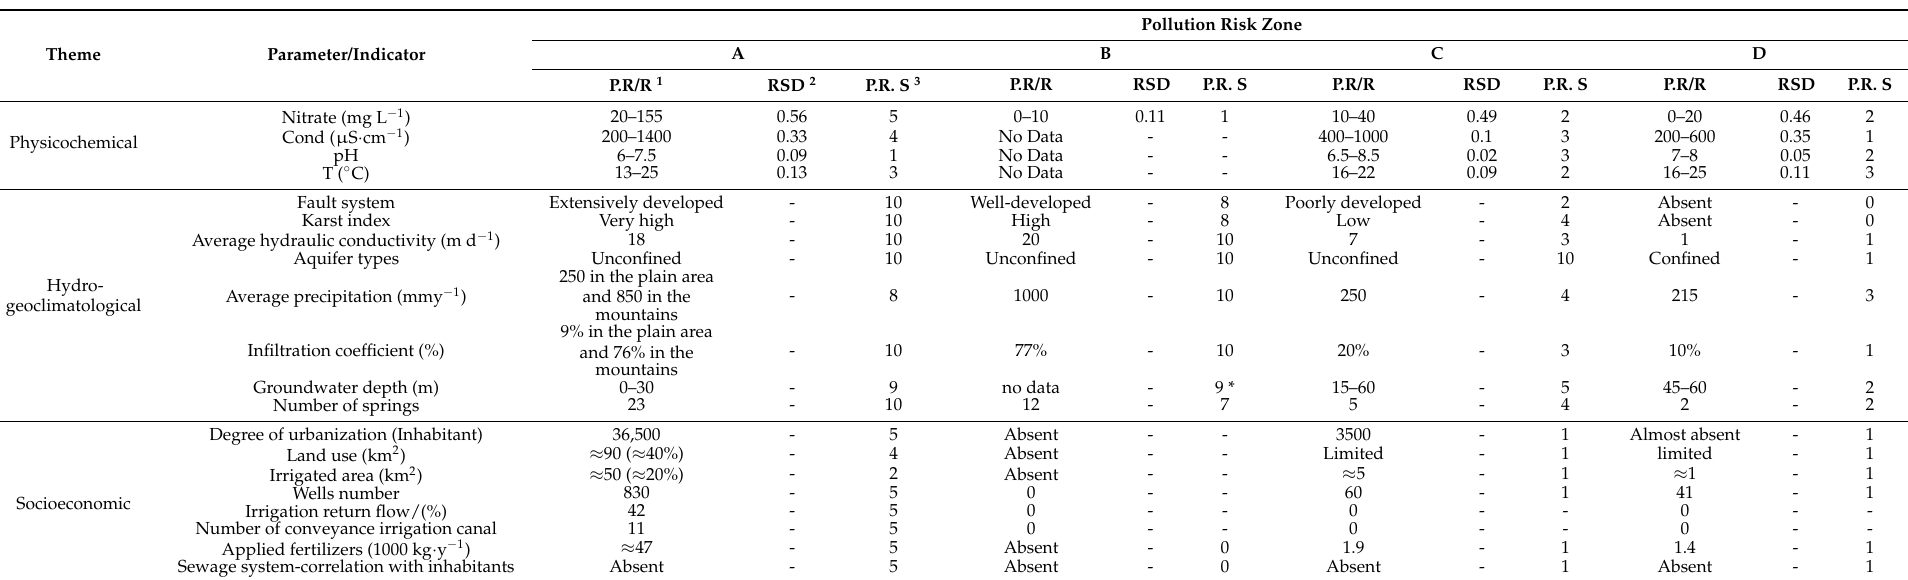
Table 2. The range of different parameters and factors used to assess the aquifer pollution risk to contamination in the